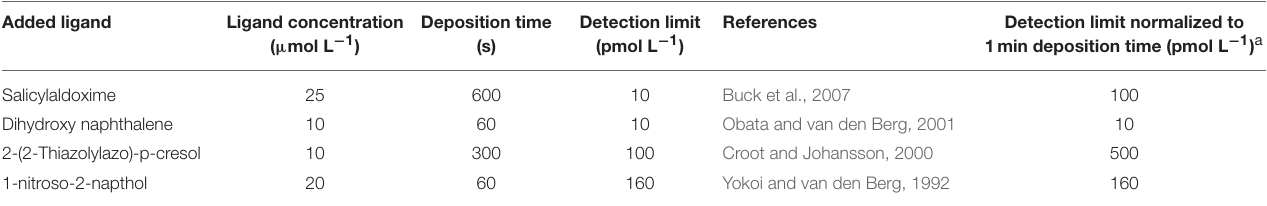
a Detection limits are also influenced by the mercury drop sizes of different electrodes, which is not accounted for here.